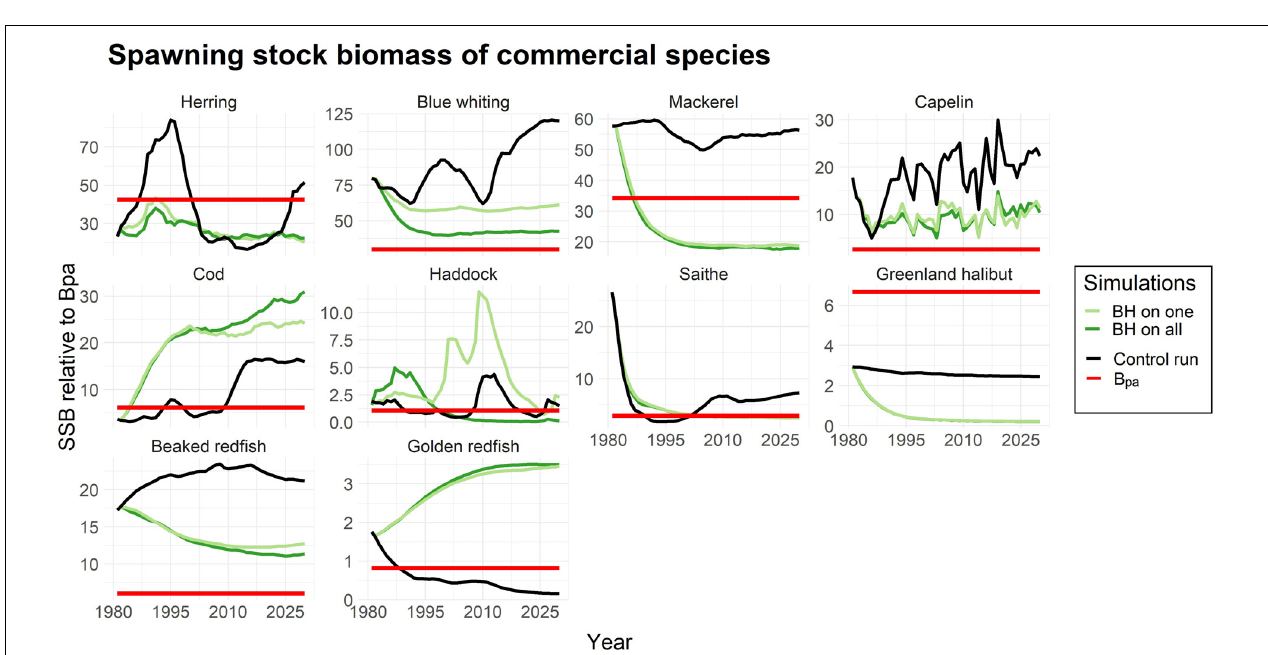
FIGURE 3 | Spawning stock biomass (SSB) of all commercial species in the study compared to the precautionary reference point (B pa ) which is marked as a red line. The SSB is given as an index for the simulations when only one species is harvested according to BH (light green), all species are subjected to BH (dark green) and a control run where traditional fishing mortalities were applied (black line).